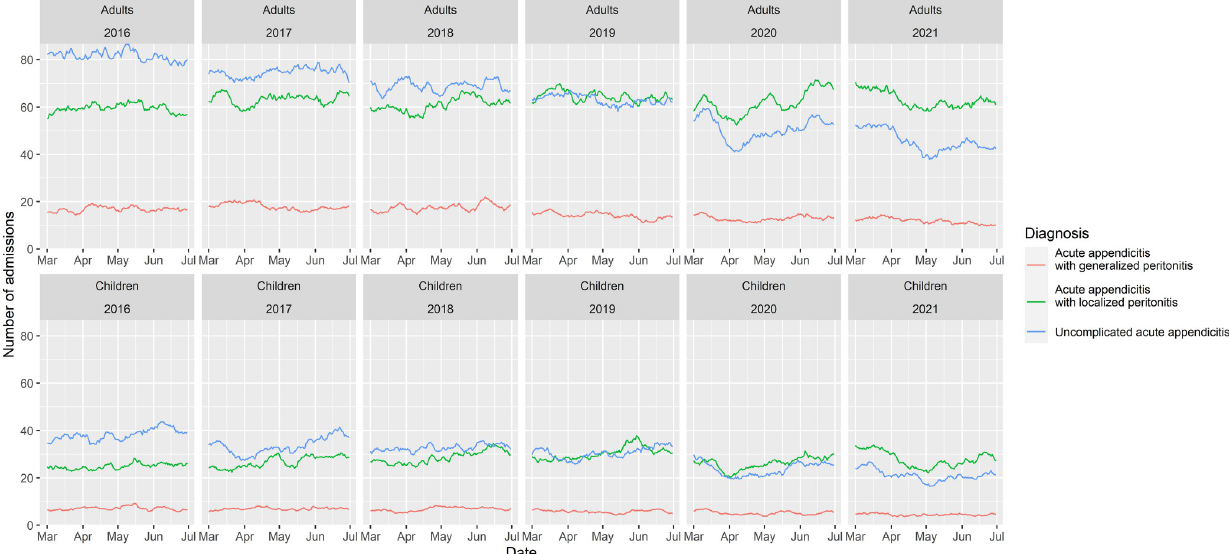
Fig 2. The trend of acute appendicitis from 2016 to 2021, stratified by age group.